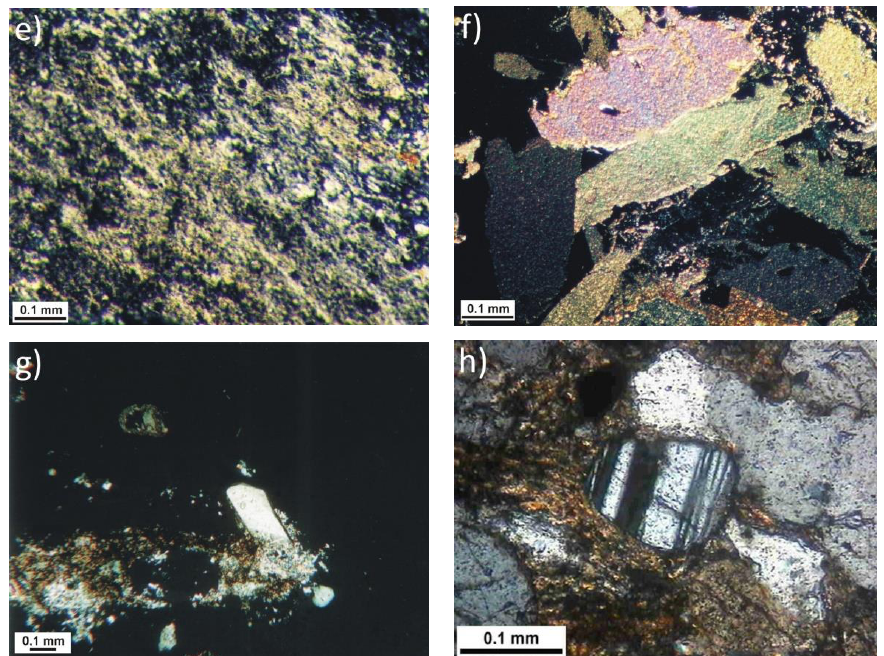
Figure 5. Mineral composition of the zuber rocks (according to [41,45,46]). ( a ) Fractures in halite filled with fine-grained anhydrite (Anh); ( b ) secondary crystallized fine-grained halite; ( c ) fluid inclusions in halite; ( d ) idiomorphic crystals of anhydrite (Anh) in a fine-grained matrix; ( e ) typical clayey-quartz fine-grained concentration with parallel grains orientation; ( f ) coarse-grained calcite concentration; ( g ) clayey-anhydrite (clay-anh) concentration with isomorphic quartz crystals; ( h ) plagioclase (plag) with xenomorphic crystals of quartz (qtz). Image ( a )—partially cross polarized light; images ( b , c )—plane polarized light; images ( d – h )—cross polarized light.